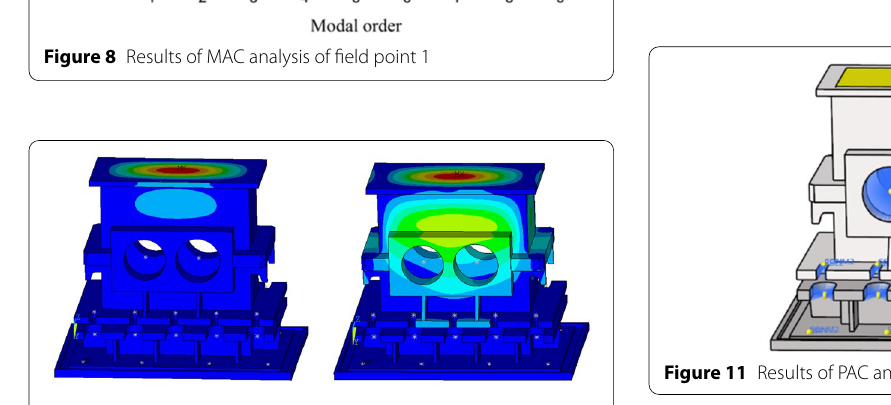
Figure 10 Panel division results